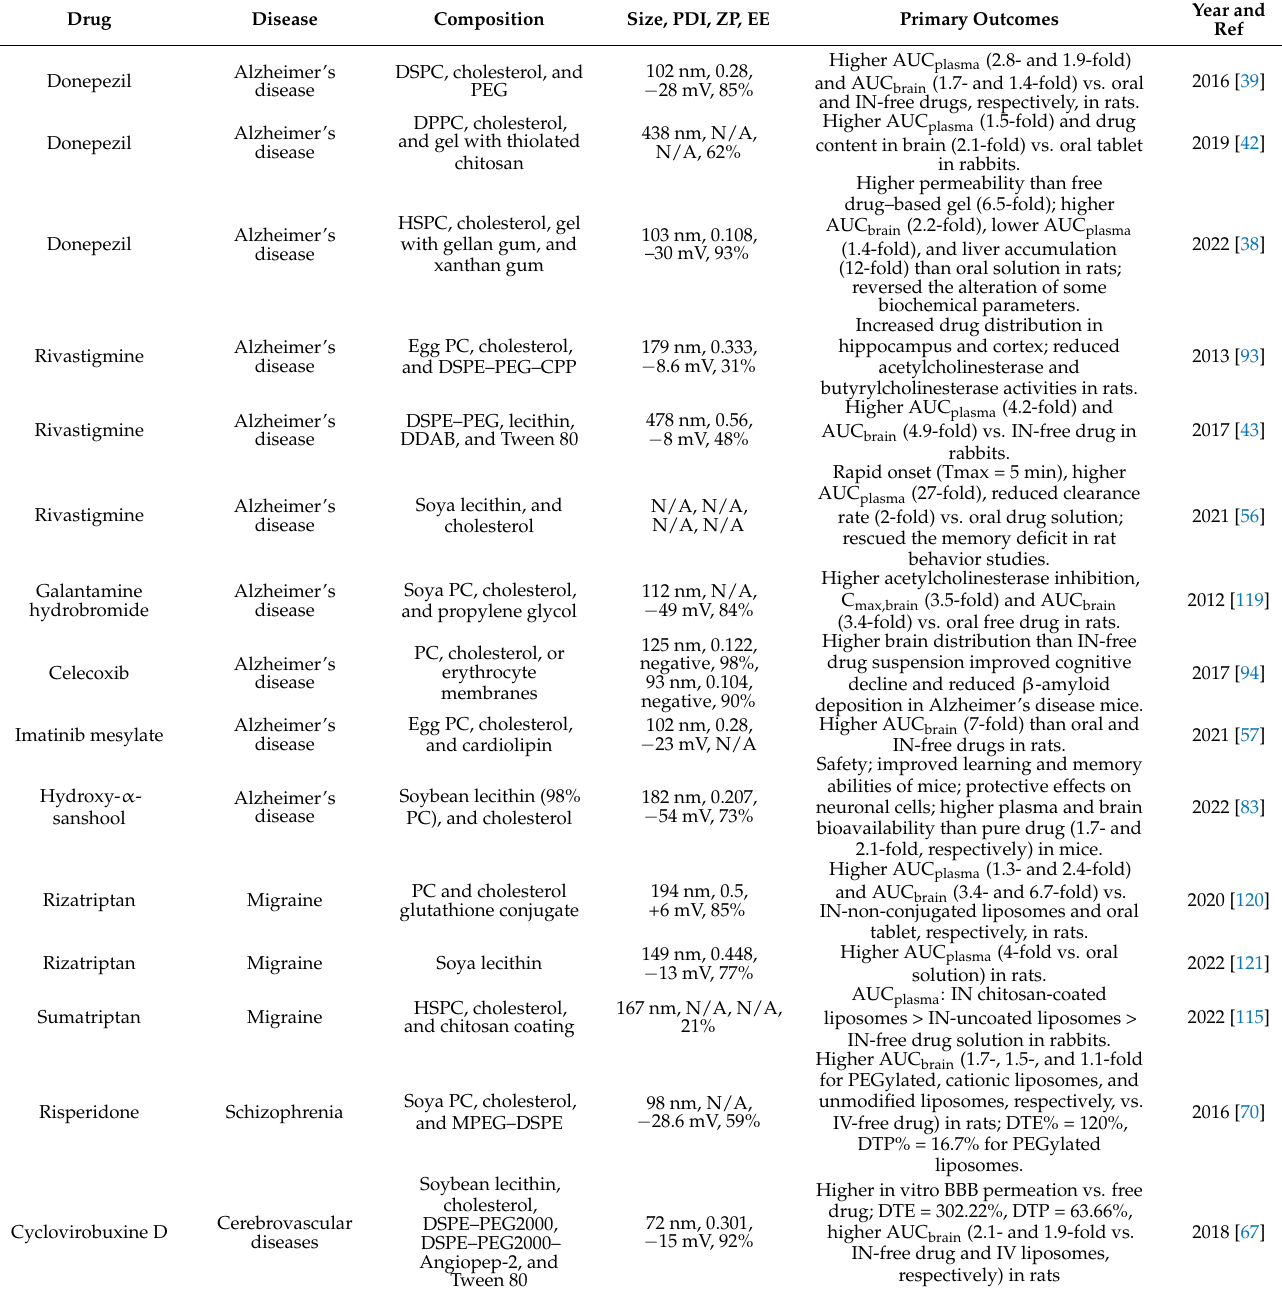
Table 1. Major features of intranasal liposomes containing small